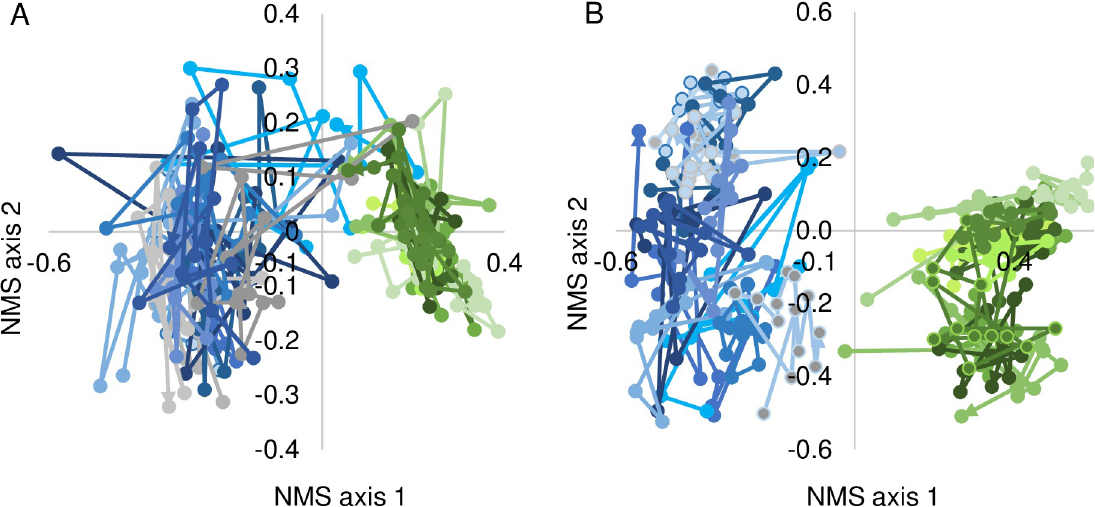
Fig 1. Non-metric multidimensional scaling (NMS) graph by (A) functional group and (B) species of plant community composition in adjacent ex-arable fields (blue and grey colors) and never-tilled fields (green colors) over 13 years. Each point represents the mean composition of vegetation across a transect located 50 m from a tillage boundary. Lines connect values from a field over 13 years of direct observation. For clarity, data from 12 of 25 randomly selected sites are shown. P = 0.030) reflecting a positive slope (0.007) in ex-arable fields (Fig 3). There was no effect of